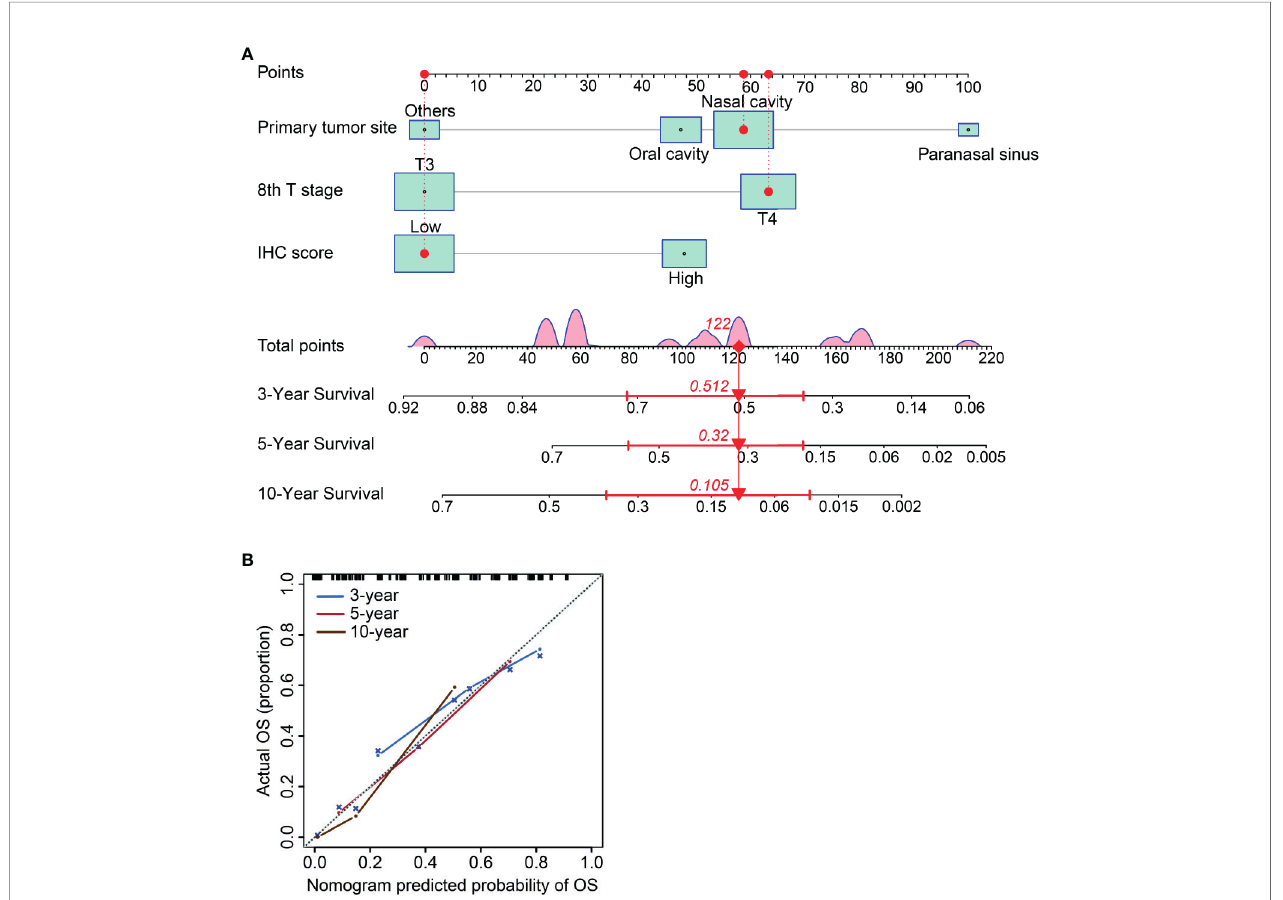
FIGURE 6 | Establishing and validating a nomogram. (A) A constructed nomogram for prognostic prediction of a patient with MMHN. The patient had a local tumor in nasal cavity, T4 stage, and low IHC score. Density plot of total points shows their distribution. For category variables, their distributions are re fl ected by the size of the box (to view boxes of IHC score, the smaller one represents high score and the bigger one represents low). The importance of each variable was ranked according to the standard deviation along nomogram scales. To make use of the nomogram, the black dots of a single patient are located on each of the variable axis. Red dots and lines are drawn up to determine the points received by each variable; the sum (122) of these points is located on the Total Points axis, and a line is drawn downward to the survival axes to determine the probability of 3-year (51.2%), 5- year (32.0%) and 10-year (10.5%) overall survival for MMHN. (B) The 3-, 5-, and 10-year OS of calibration curves were used to assess the predictive ability of the nomogram. Dashed lines along the 45-degree line represented that the predicted probabilities are equal to the actual